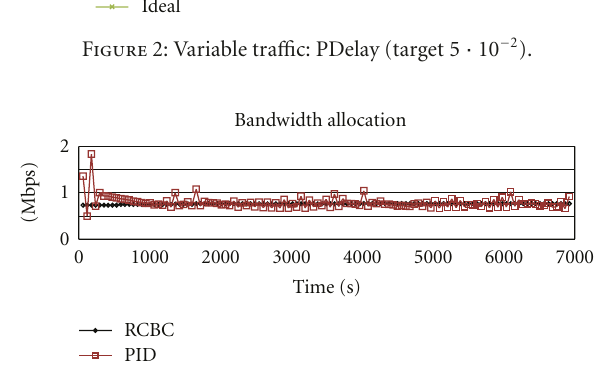
Figure 3: Variable tra ffi c: bandwidth allocations.